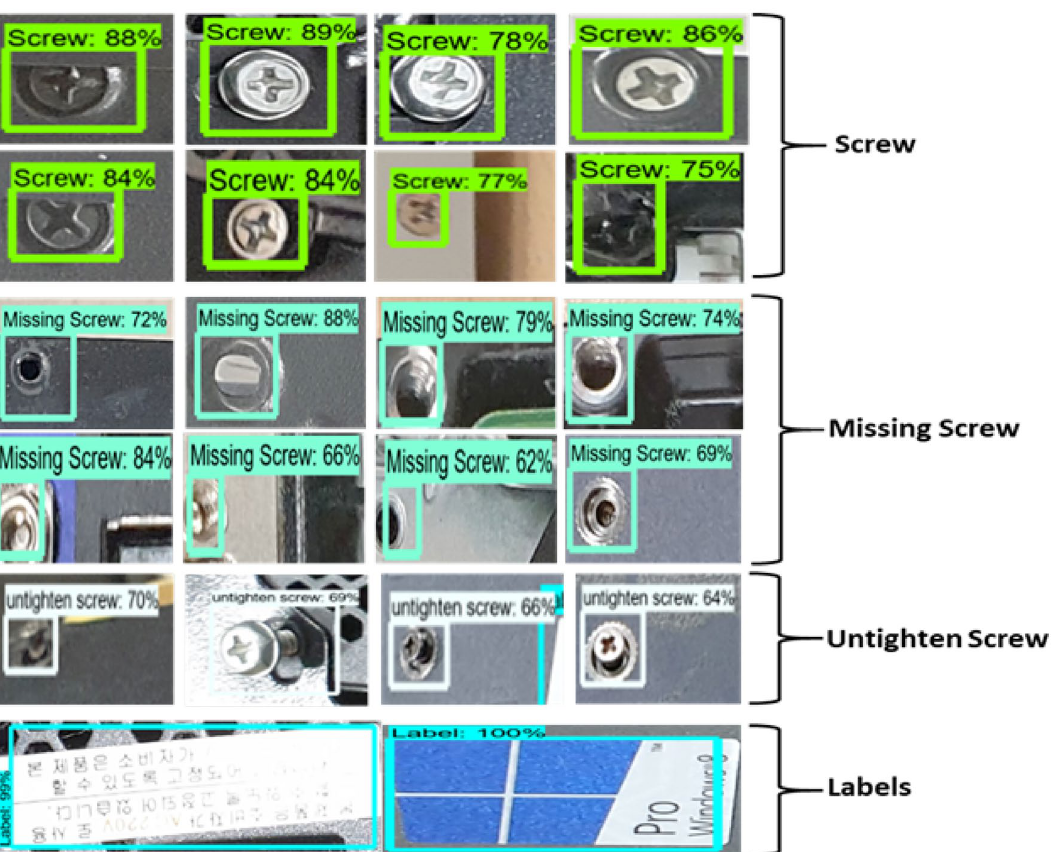
Figure 7. Detection results of the model. The model is tested for four classes, i.e., screws, missing screws, untighten screw, and